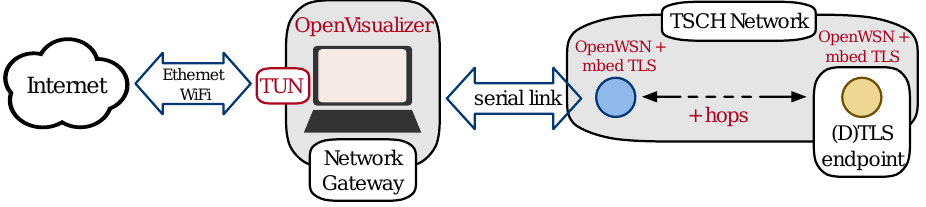
Figure 4. Experimental setup.